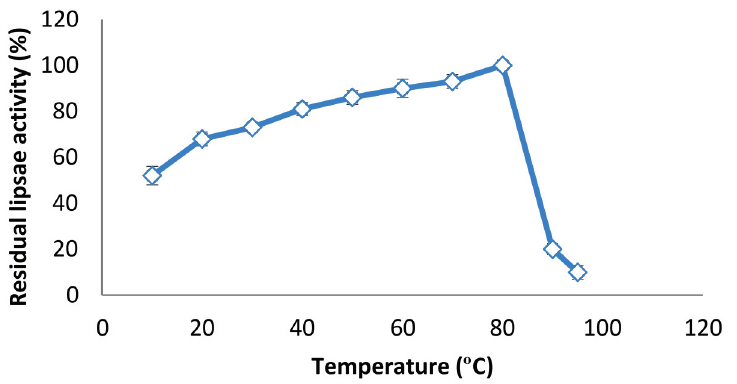
Figure 5. Effect of different temperatures on the enzyme activity of lipase from pumpkin seed. The residual lipase activity was determined after incubation of lipase at different temperatures.